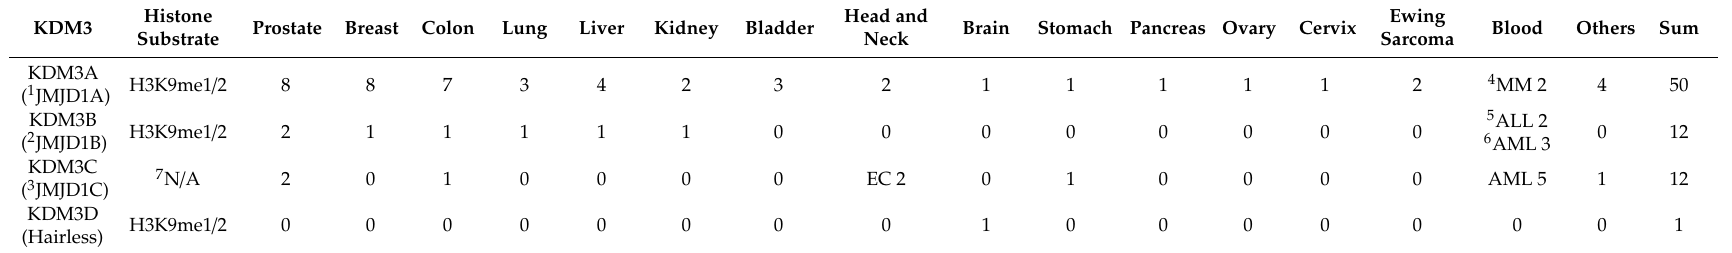
Table 1. Number of published research papers on cancer and